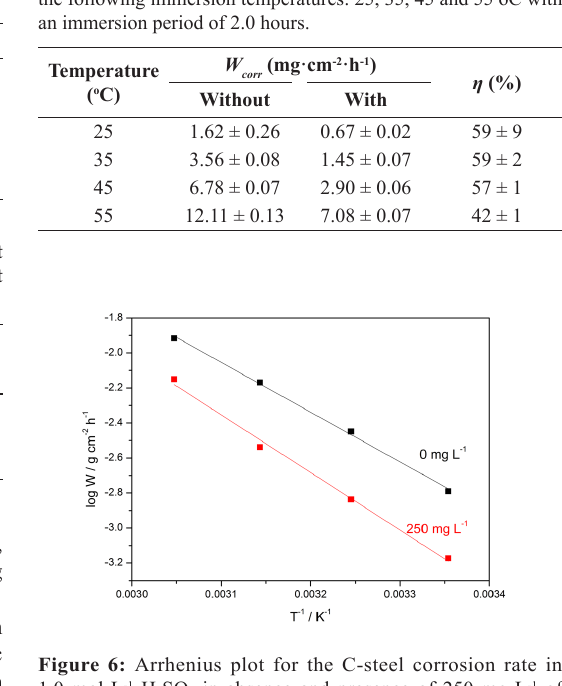
Figure 6: Arrhenius plot for the C-steel corrosion rate in 1.0 mol·L -1